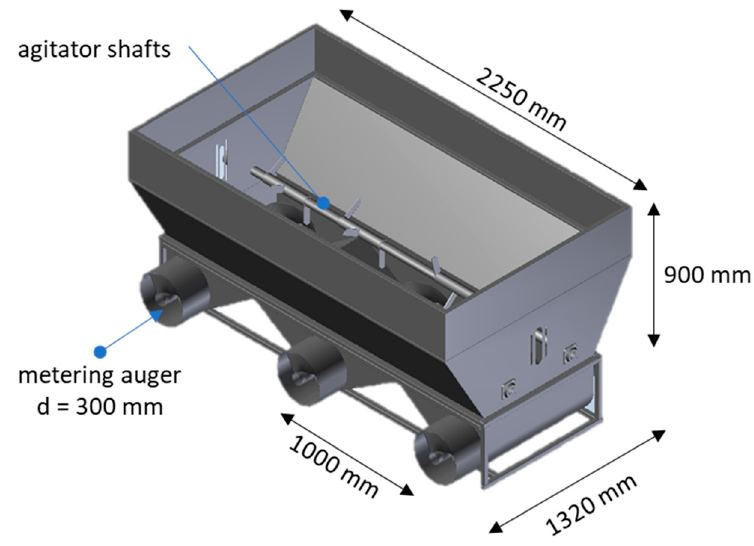
Figure 6. Compost tank with two hydraulically driven mixing and three metering augers. Three open metering augers at a distance of one meter are placed in the bottom of the tank. They take up the material from the tank and discharge it via the respective injection tine. The screw diameter was selected to ensure a reliable flow of the material from the tank into the screw. Bridging over the screw must be prevented and its complete filling ensured. On the other hand, the material must be accurately metered and fed to the injec- tion tine via a hydraulic flow valve. A shaft diameter of 300 mm proved to be optimal for the materials investigated. Depending on the driving speed, the empirically determined necessary auger speeds of 25 to 55 rpm are suitable for the targeted output quantity of 1–